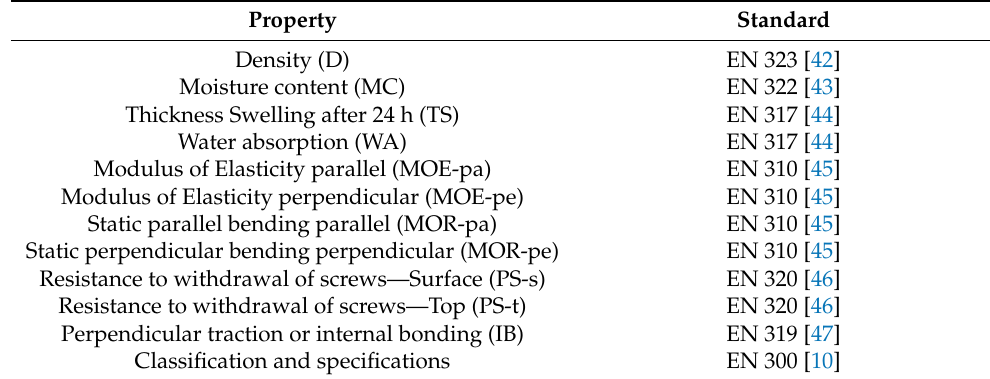
Table 2. Physical and mechanical